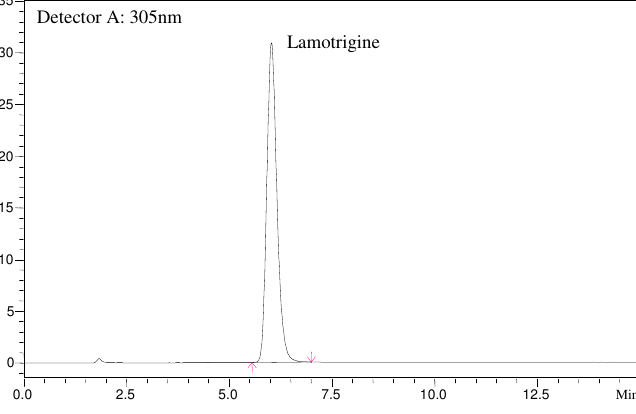
Figure 1. A model chromatogram showing the separation of